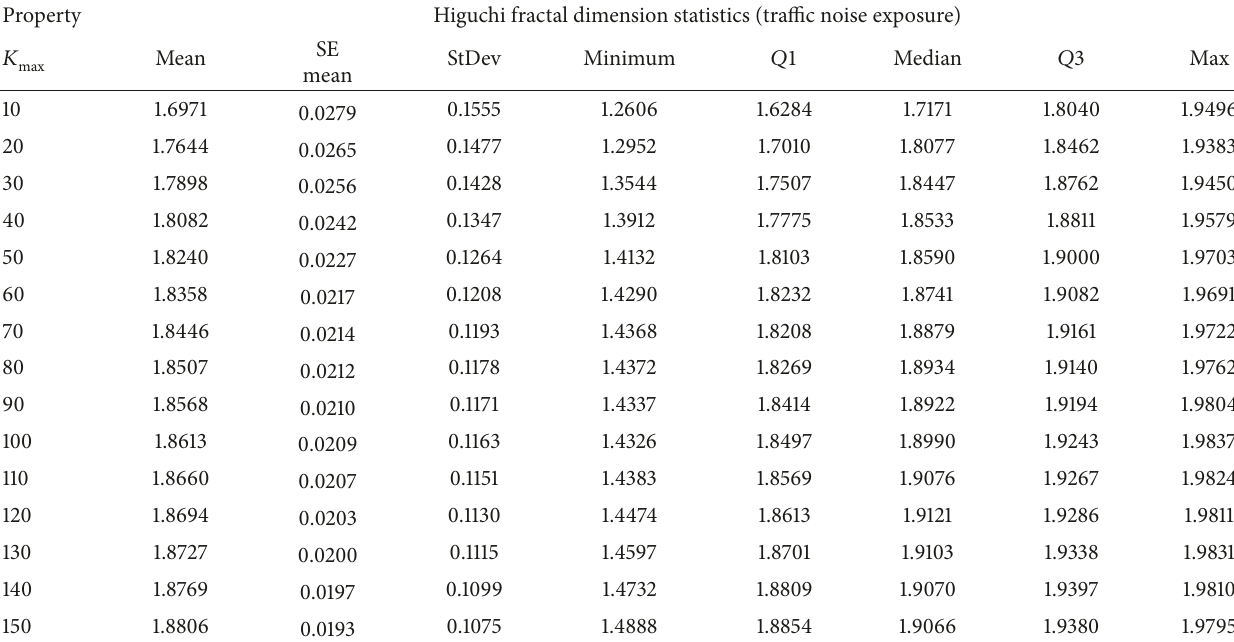
Table 5: Higuchi fractal dimension statistics through 𝐾 max between 10 and 150 at intervals of 10 in the traffic noise protocol.